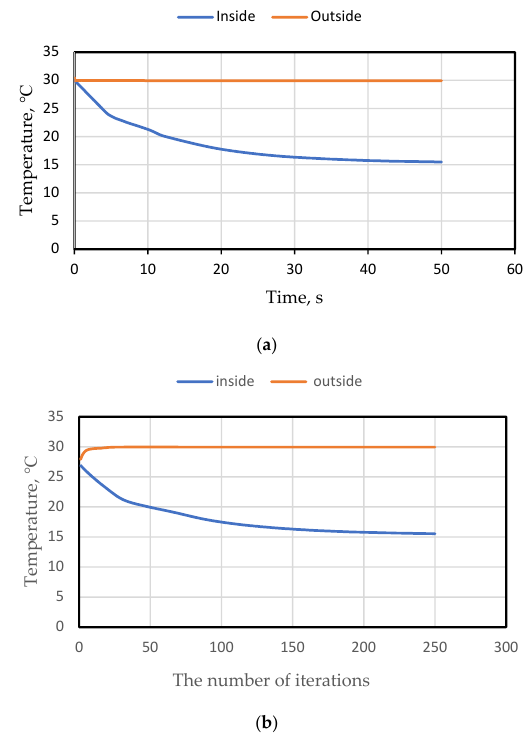
Figure 3. Average temperature: ( a ) transient; ( b ) steady.